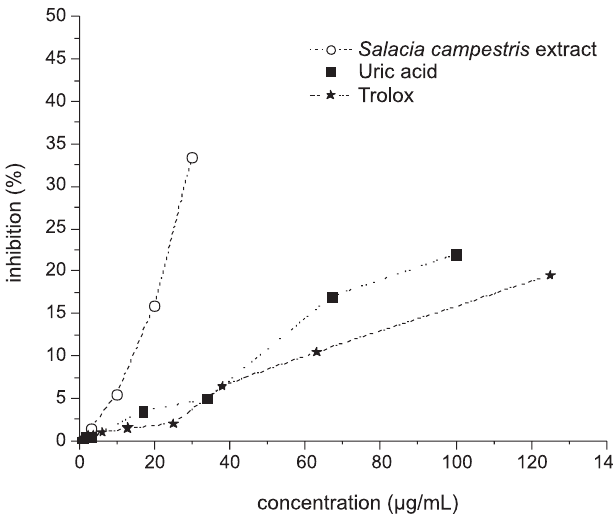
FIGURE 4 - Superoxide anion radical Scavenger action by S.